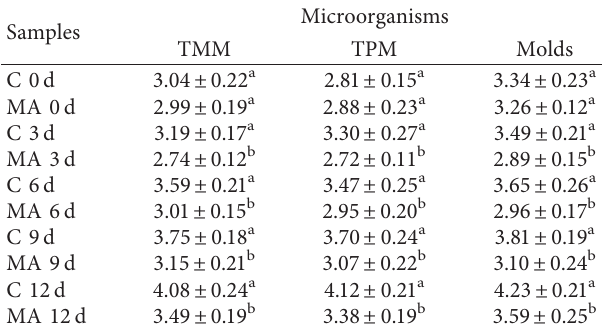
Table 2: Microbial loads of control (C) and coated ( O. ficus-indica mucilage in combination with ascorbic acid-MA) strawberry fruit samples during storage at 4 °